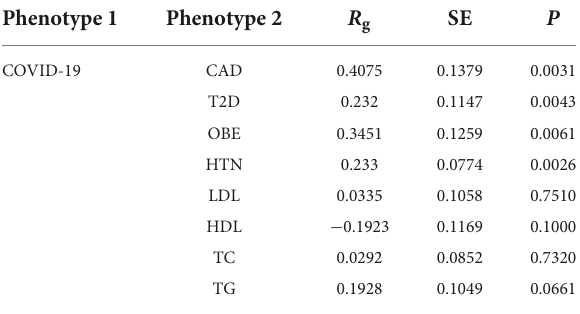
TABLE 1 Genetic correlation between coronavirus disease 2019 and cardiac